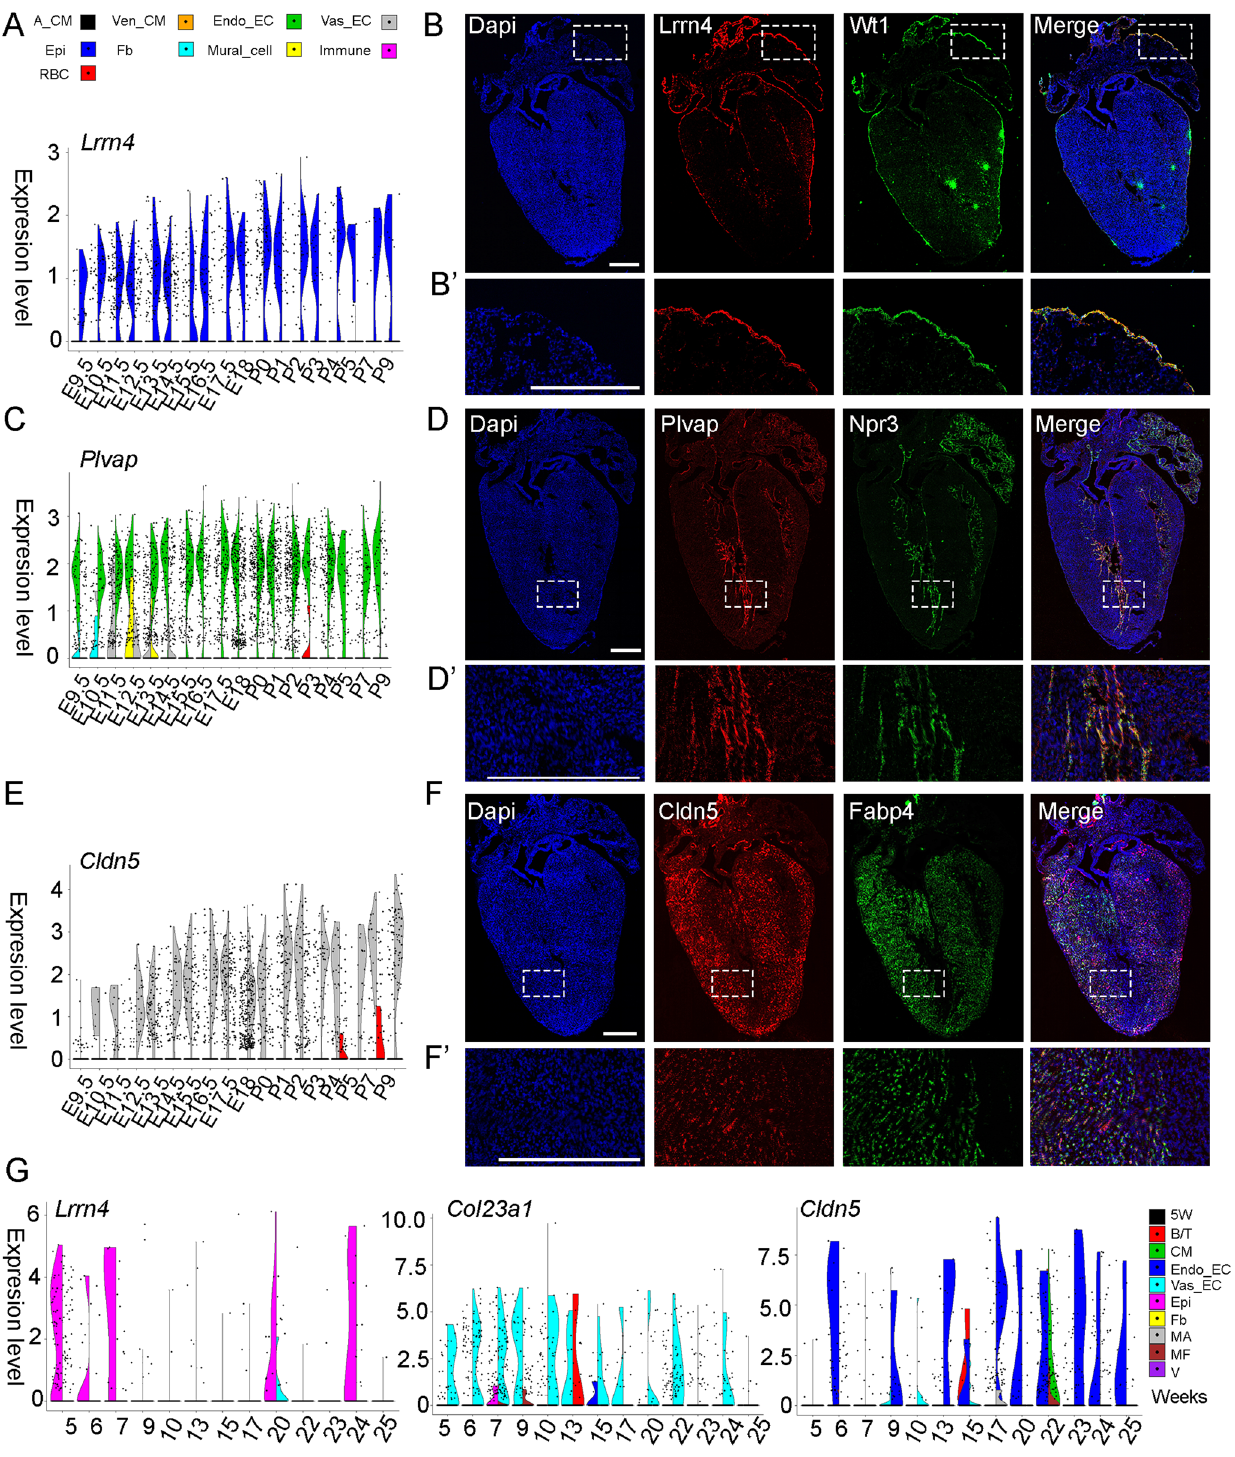
Fig. 5 | Identi fi cation ofcell type-speci fi c genes. A Lrrn4 is speci fi cally expressed in epicardial cells at all stages. B , B ’ In situ RNA staining of Lrrn4 and known epicardialcellmarker Wt1 con fi rmedtheepicardium-speci fi cexpressionof Lrrn4 in P2 hearts. C Plvap is speci fi cally expressed in Endo_EC at most stages. D , D ’